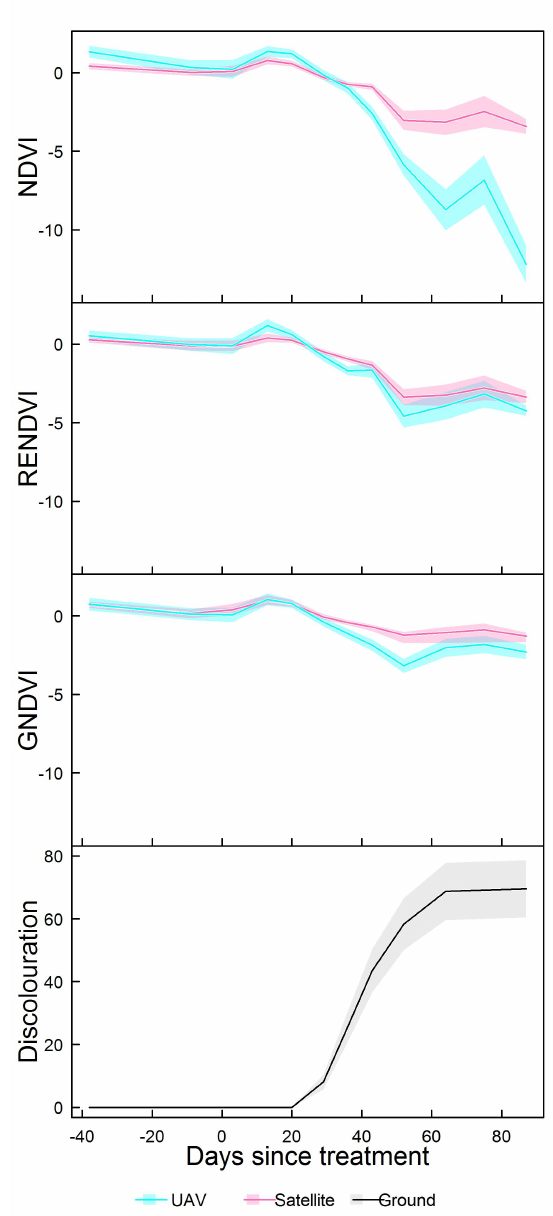
Figure 5. The change in the de-trended vegetation indices and field measured discolouration plotted against days after treatment. The solid line shows the mean at each time step and the shaded area shows the confidence interval. For each spectral index the values relate to the mean value of pixels within a cluster. For the ground measured discolouration the values represent observations of the field